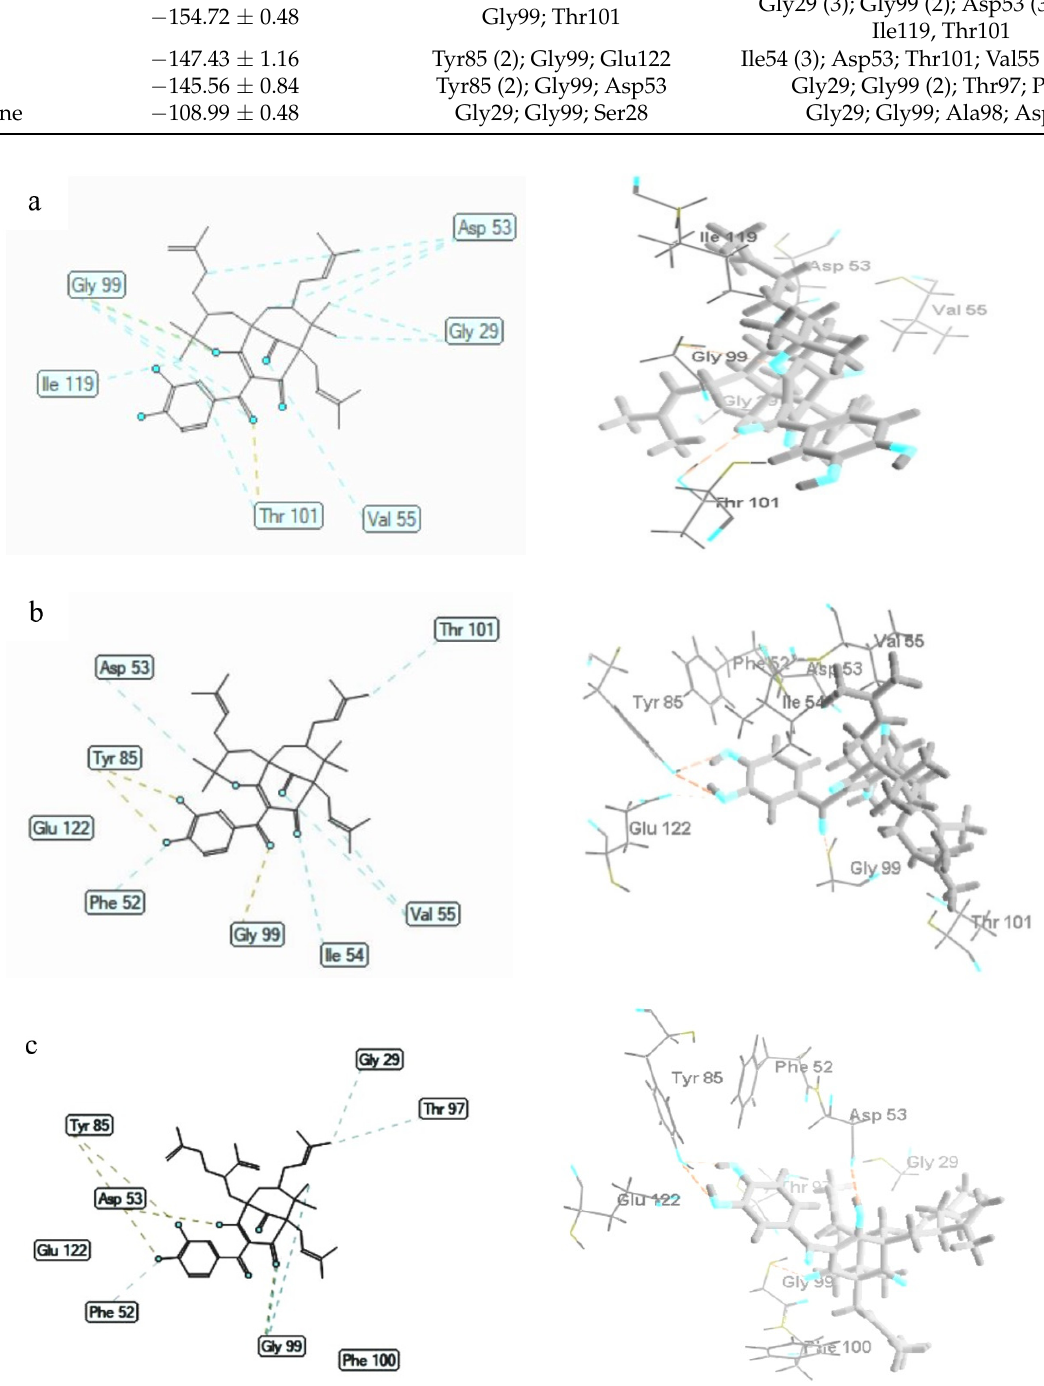
Figure 4. The 2D and 3D interaction of 1 ( a ), 2 ( b ), and 3 ( c ) with Plasmodium falciparum lactate dehydrogenase enzyme (1CET). Hydrogen bonds are shown as yellow dotted lines while steric interactions are depicted as blue dotted lines. Carbon atoms are represented in gray, oxygen in blue, and hydrogen in black.